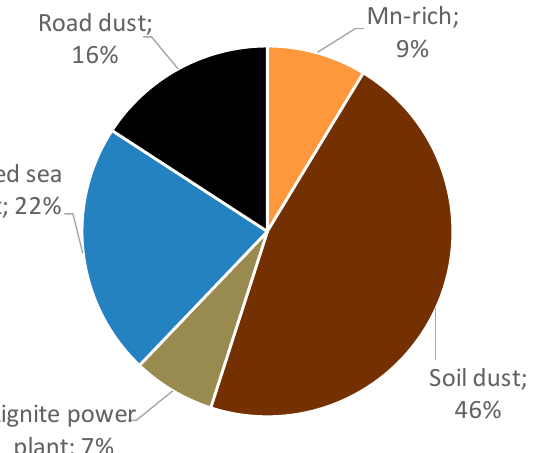
Figure 4. The average source contributions for the region of Northern Greece (based on all 105 moss samples).